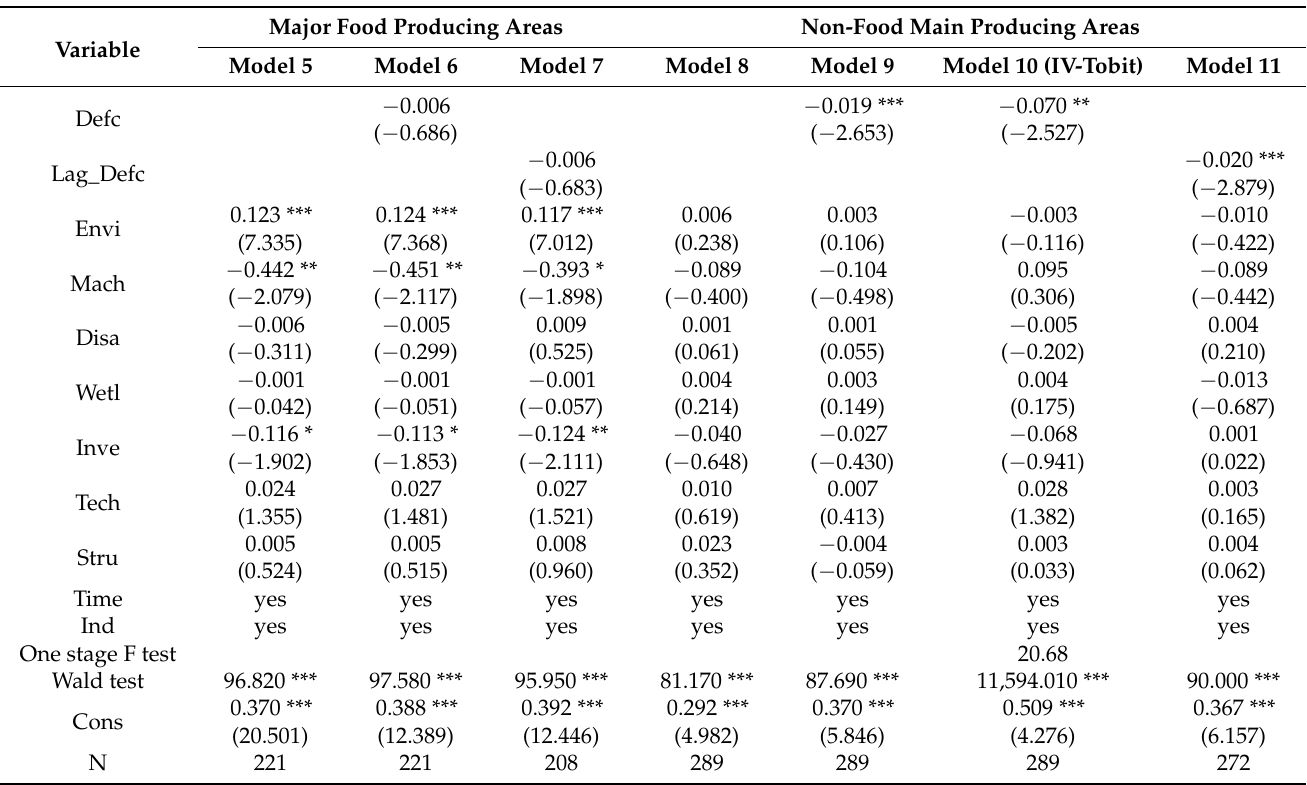
Table 4. Regression results of decentralized food crop cultivation and WLF nexus in sub-production